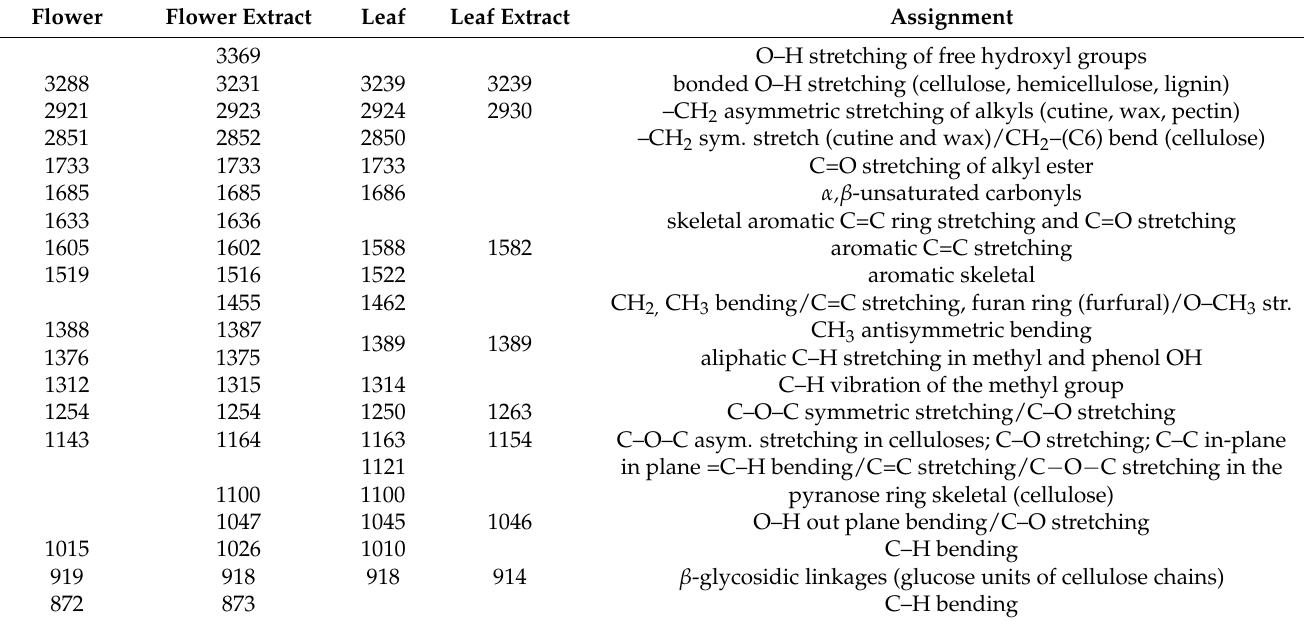
Table 1. Main bands in the infrared spectra of S. nigra flowers and leaves, and those of their aqueous ammonia